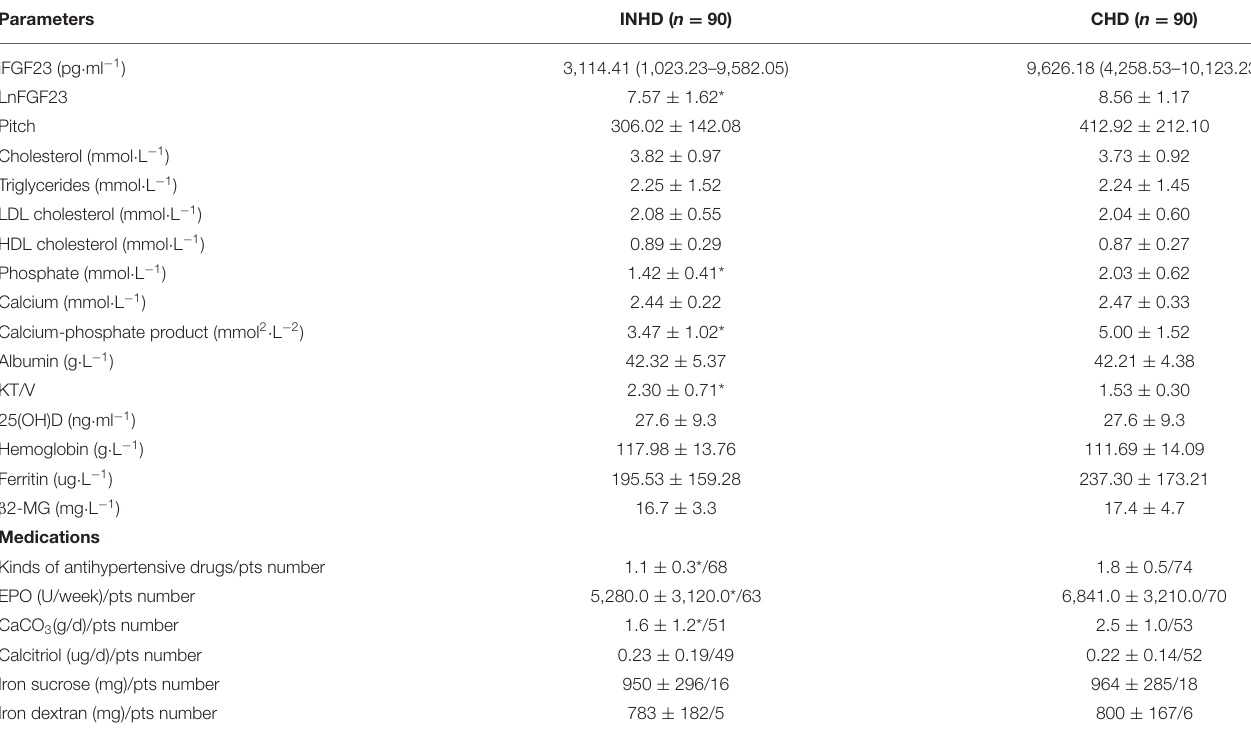
TABLE 2 | Comparison of parameters between CHD and INHD at 1-year follow-up. Parameters